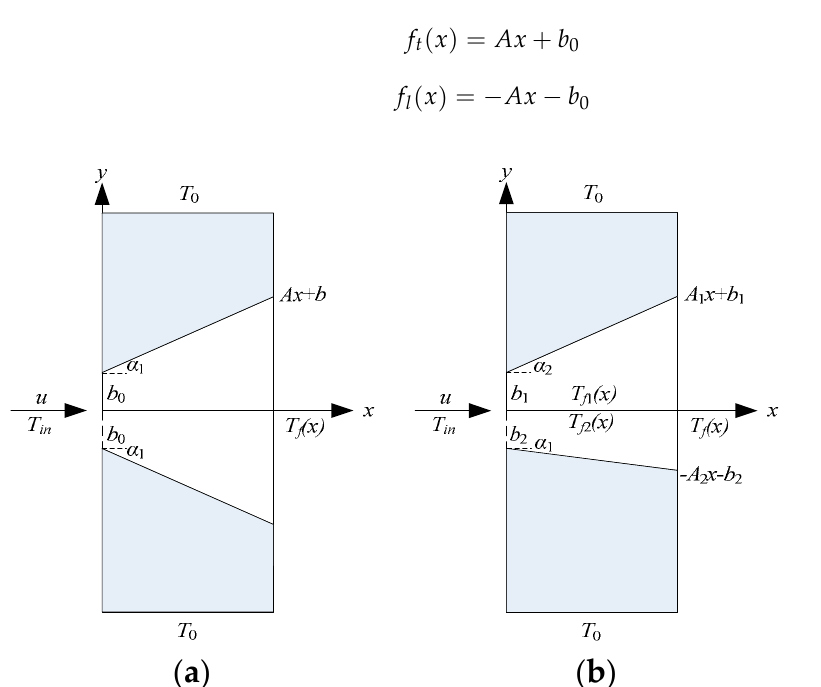
Figure 2. A conceptual diagram of heat flow through a rock fracture. ( a ) Symmetric fracture wedge; ( b ) Asymmetric fracture